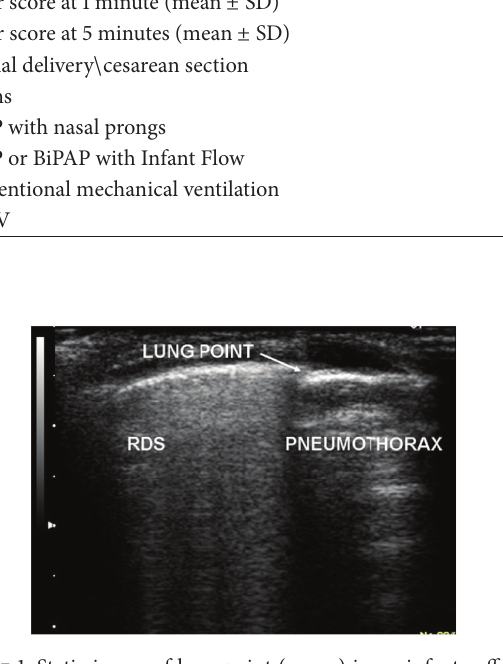
Figure 1: Static image of lung point (arrow) in an infant suffering from RDS. Note the coalescent B lines in the left side of the image (sign of RDS); they suddenly disappear at the edge of PTX (lung